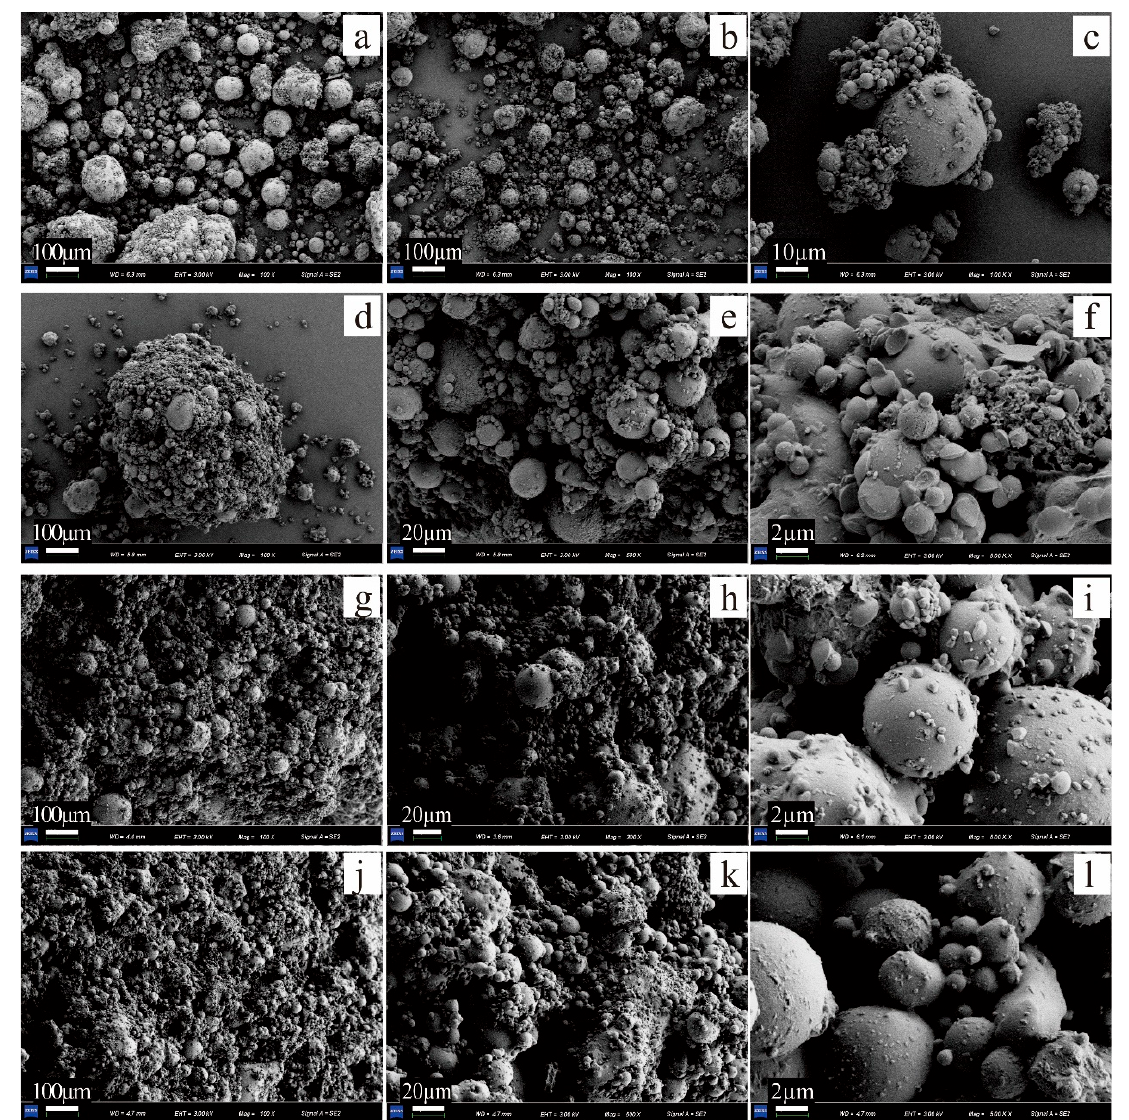
Figure 5. SEM images of FA cured with different treatment solutions. ( a , b ) the looseness of the samples treated by PAM and EICP; ( c ) the contact relationship between FA particles of the samples treated by EICP; ( d – f ): T-1-0.3-460-0.4; ( g – i ): T-1-0.3-460-0.6; ( j – l ): T-1-0.3-460-0.8. XRD patterns are often used as a tool to distinguish mineral types [34]. The peaks The pH and CO 32 − concentration increased in the solution due to the hydrolyzation and intensities of crystals of the anhydrous forms for CaCO 3 , namely vaterite (hexagonal), of urea by urease when added the EICP was in the PAM solution. At the same time, the aragonite (orthogonal), and calcite (rhombohedral), were different in XRD patterns [35]. negatively charged groups formed by PAM hydrolysis also had high cohesion energy for The results showed that calcite appeared in the samples treated by EICP and PAM-EICP opposite charges (such as Ca 2+ ) and provided binding sites for Ca 2+ [37] to make the Ca 2+ compared with the control group, and the peak intensity of calcite formed in the samples concentration locally supersaturated and accelerate the nucleation process of CaCO 3 . After that, the long PAM chains not only selectively adsorbed on the nano-CaCO 3 crystal surface treated by PAM-EICP was higher than that of the samples treated by EICP only (Figure but also intertwined and wrapped on the FA particles, forming a relatively stable and 6). densely filled spatial skeleton mesh structure (Figure 7c), which played a role of flexible filling and reinforcement between the pores of FA particles and improved the physical structure of the FA body to reduce the generation of